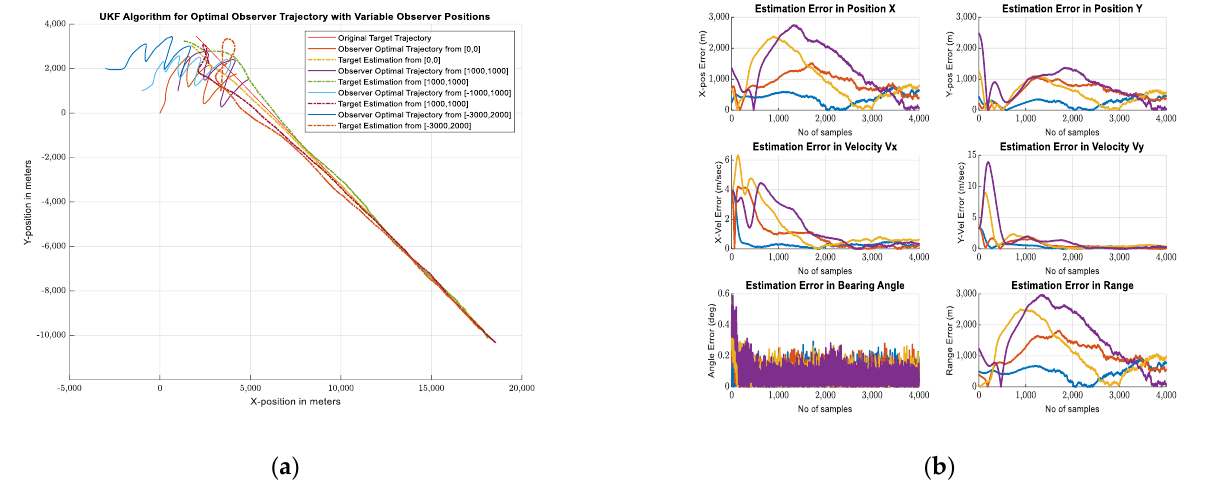
Figure 6. ( a ) Estimated Trajectories for Variable Initial Positions of Observer using UKF and; ( b ) Estimated Errors for Position, Velocity, Range, Bearing Angle for Optimal Observer path.